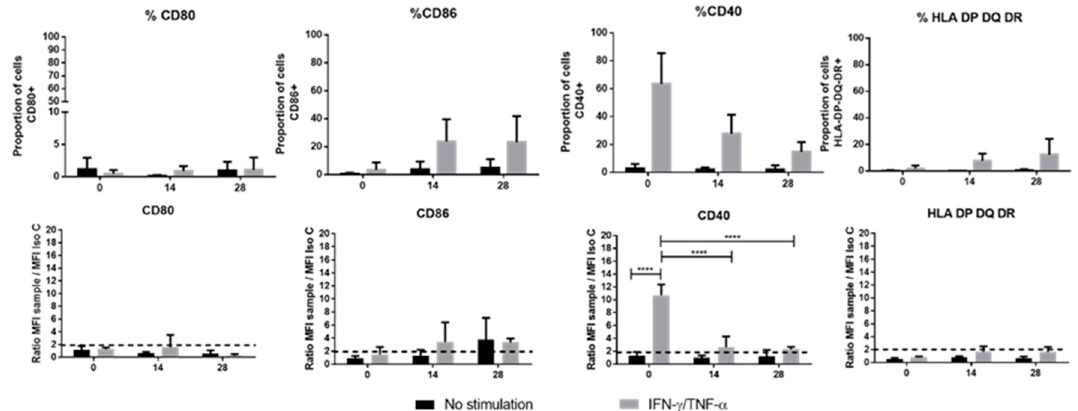
Figure 4. Main molecule expression related to the immunological synapse. These molecules (CD80, 86, 40 and Human Leucocyte Antigen (HLA)-DP-DQ-DR) were studied on Day 0 (monolayer) and during chondrogenic di ff erentiation (day 14 and 28) in two conditions (with Interferon- γ (IFN- γ ) and Tumor Necrosis Factor- α (TNF- α ) stimulation (grey color) or without stimulation (black color). Results were obtained by flow cytometry and calculated in proportion of positive cell for each marker (up results) and ratio of mean fluorescence intensity of the sample compared with the isotype control (down results). The dotted lines represent the expression level for each molecule ratio higher than 2 between sample and isotypic control (down results). Data are expressed as mean ± SD ( N = 3 independent cords minimum), **** p < 0.0001.